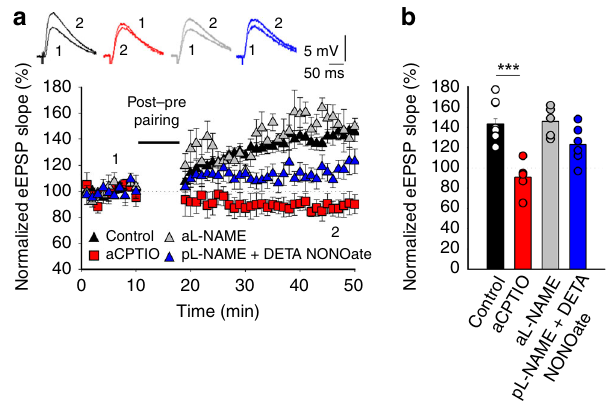
Fig. 6 NO is necessary for astrocytic release of gliotransmitter(s) and t-LTP induction. a t-LTP is prevented by loading cPTIO (100 µ M ) into the astrocyte via the recording pipette but not by loading L-NAME (100 µ M ). When L-NAME is loaded into the postsynaptic neuron and a NO donor (DETA NONOate, 5 m M ) added in forms of puffs over astrocytes, t-LTP is recovered. The EPSP slopes monitored in paired control slices (black triangles, n = 11) are shown and in slices treated with acPTIO (red squares, n = 6), aL-NAME (gray triangles, n = 6) and pL-NAME + DETA NONOate (blue triangles, n = 6) are shown. The traces show the EPSP before (1) and 30 min after (2) pairing. b Summary of the results. *** p < 0.001, one-way ANOVA + Holm – Sidak. The error bars represent the S.E.M. Source data are provided as a Source Data fi